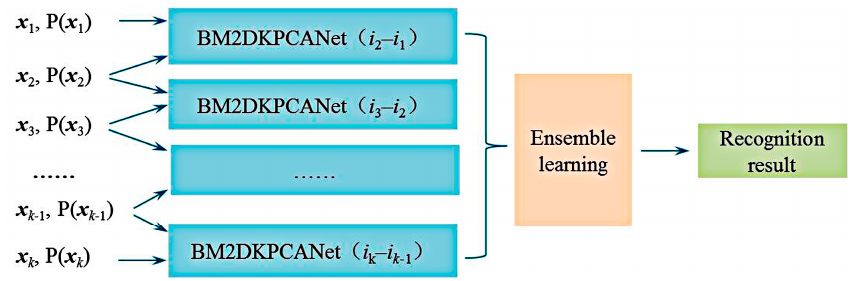
Figure 3. Multi-view classifier.